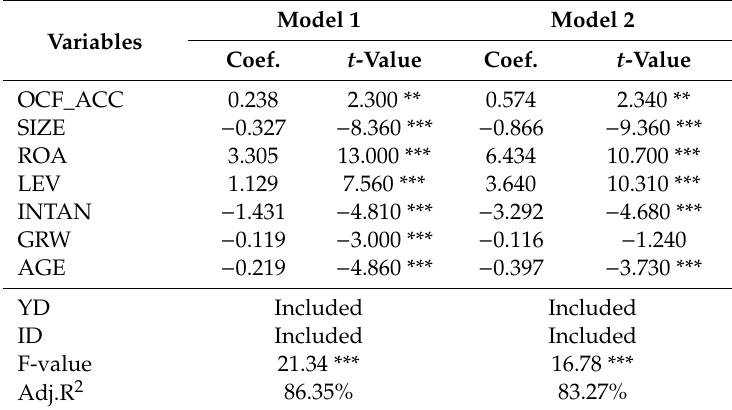
Table 10. Analysts’ cash flow forecasts accuracy and firm